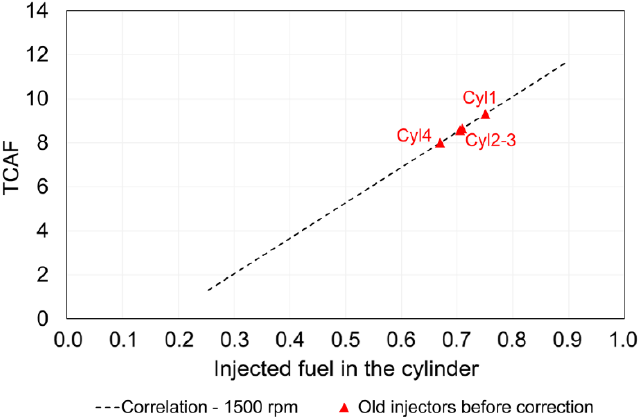
Figure 20. Linear correlation between the TCAF and the fuel mass flow injected in each cylinder at 1500 rpm obtained with the new set of injectors and values obtained with the old set of injectors at 1500 rpm and full load. Data is normalized with respect to the maximum injected fuel quantity.